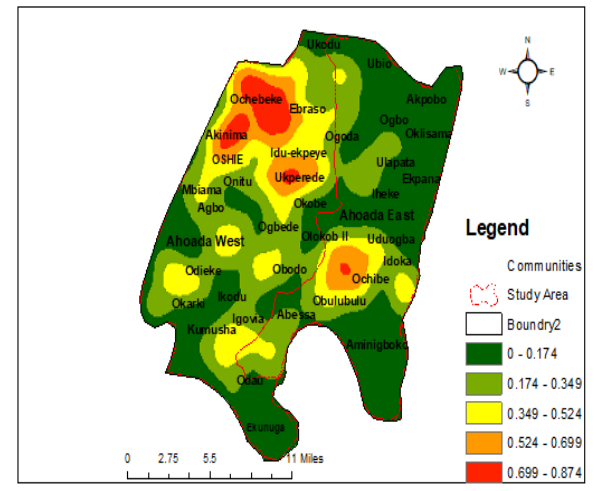
Figure 6. Oil spill hotspot map of KDE of the Niger